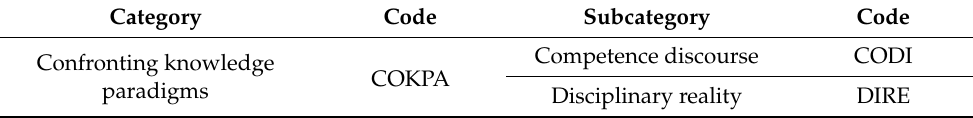
Table 3. Sections of the general category system on which this work is